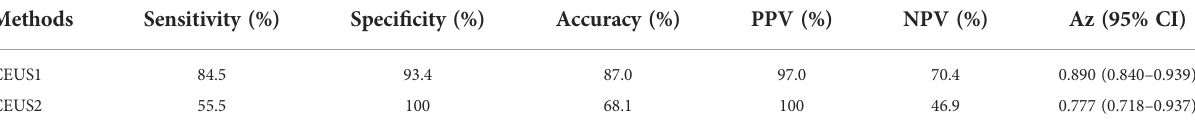
TABLE 5 Diagnostic performance for discrimination between benign and malignant CCLNs.